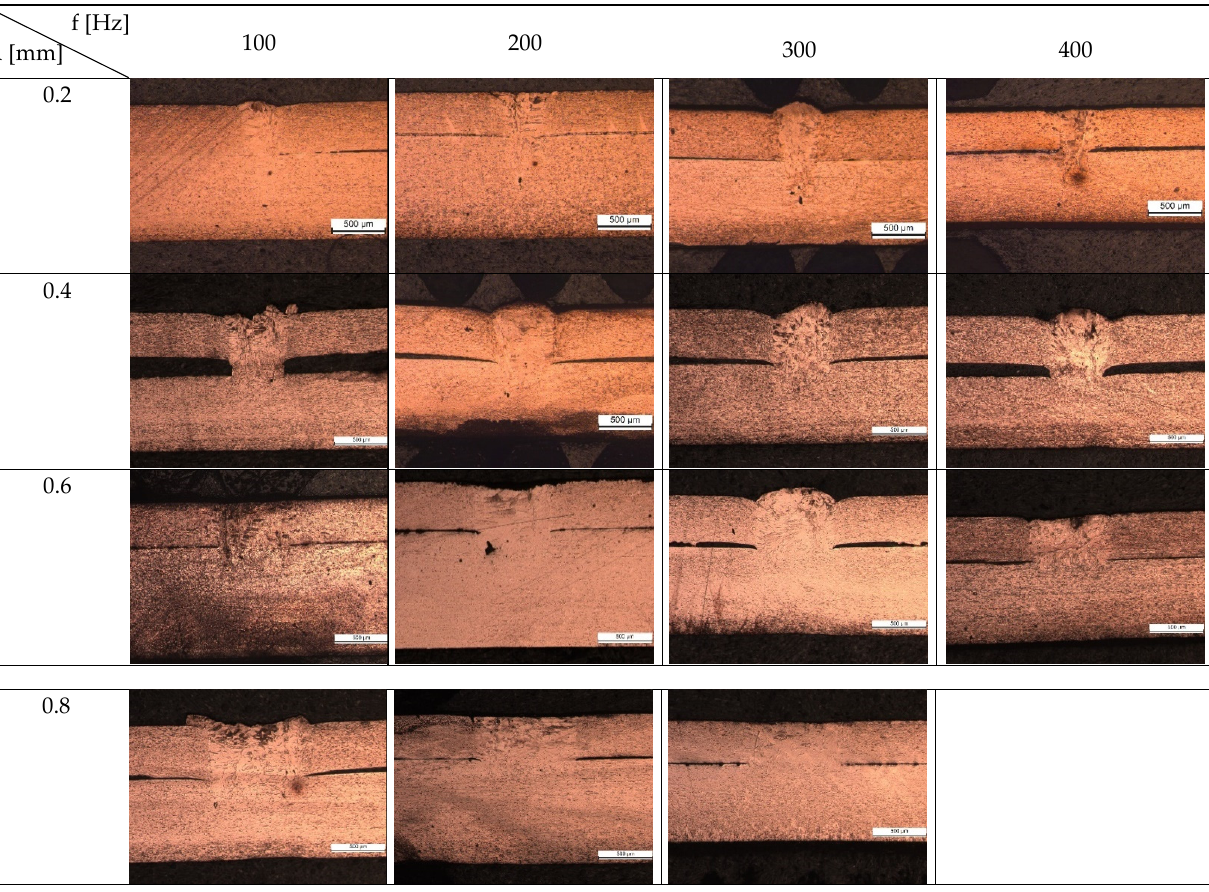
Figure 9. Cross-section of the welds with different oscillating amplitudes (0.2 mm, 0.4 mm, 0.6 mm, and 0.8 mm) and oscillation frequencies (100 Hz, 200 Hz, 300 Hz, and 400 Hz) (A: oscillating amplitude; f: oscillating frequency).